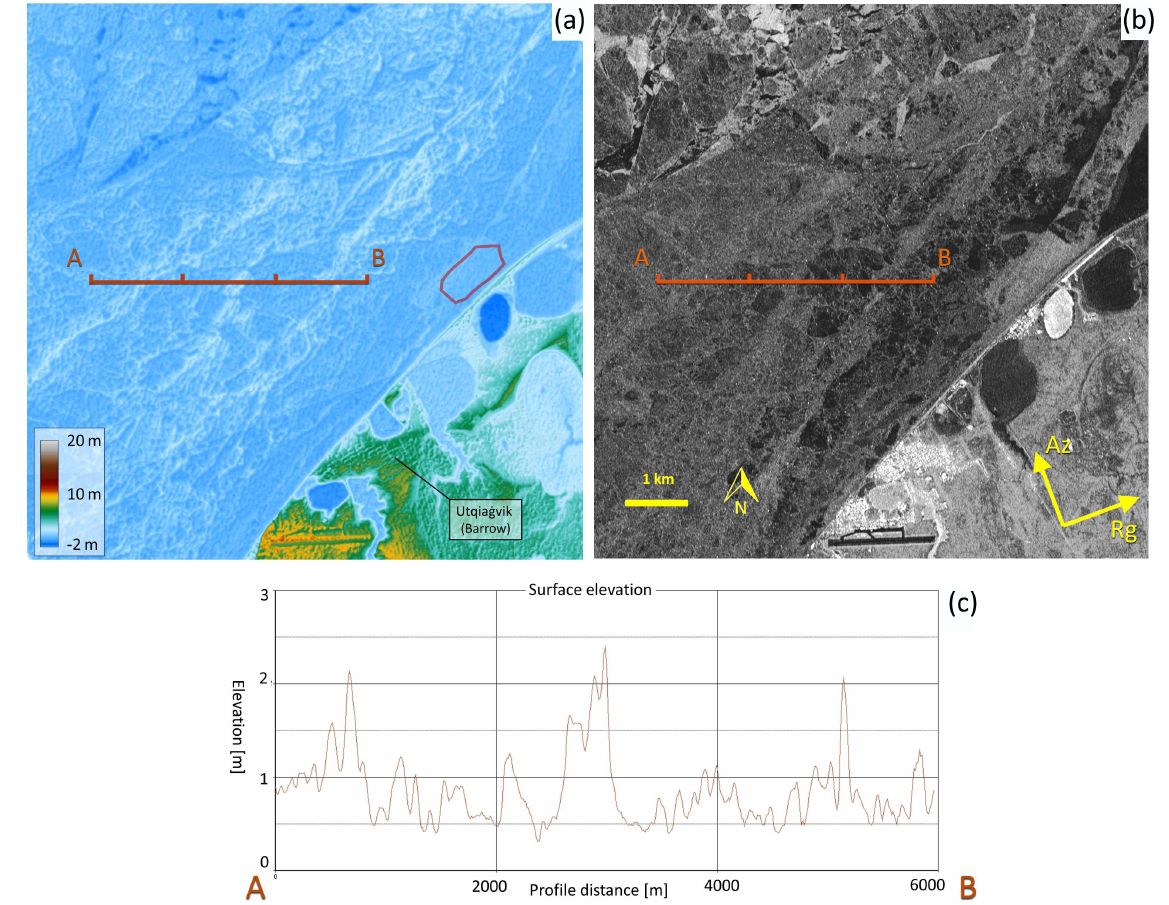
Figure 2. (a) Surface topography map close to the coastline of Pt. Barrow, derived from data acquired on 29 March 2015. Shown is a subset of the full satellite scene. The sampling distance is 12m. Red polygon: area for estimating the height error (see text). (b) Corresponding TanDEM-X amplitude image in ground-range geometry. The azimuth (Az) and range (Rg) directions of the SAR acquisition are indicated. The A–B line in (a) and (b) shows the location of the surface topography profile depicted in (c) , with corresponding tick marks. ©DLR e.V. 2015 and ©Airbus DS Geo GmbH